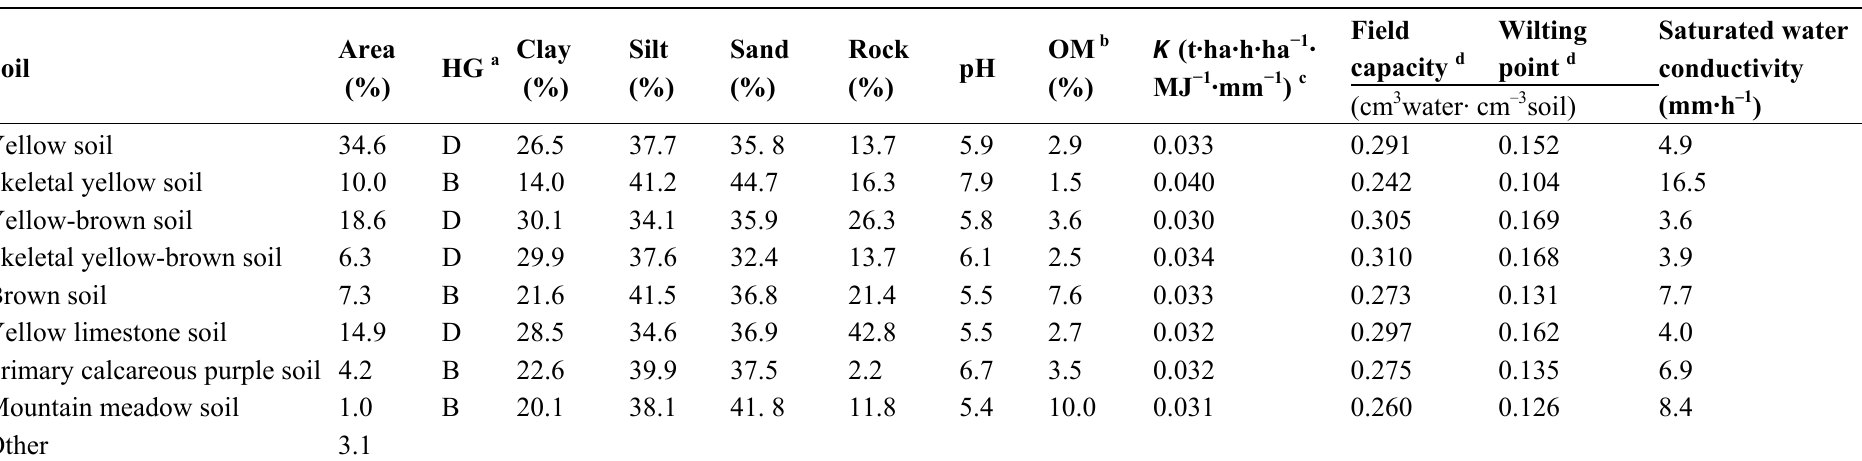
Yellow limestone soil Primary calcareous purple soil 4.2 Mountain meadow soil